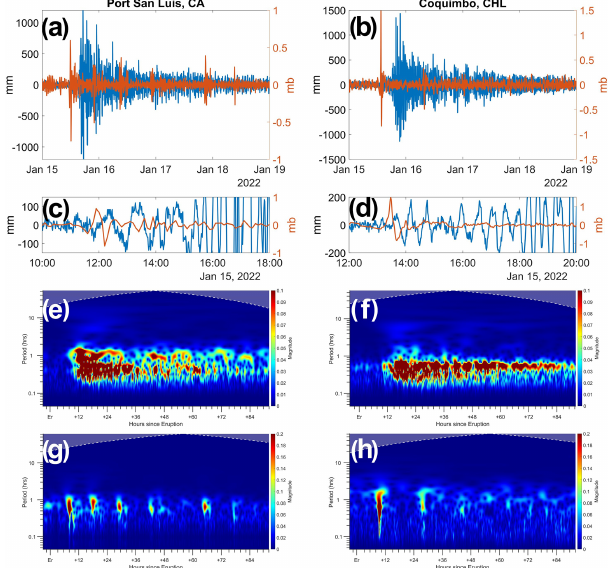
Figure 5. Residual WL (blue, mm) and detrended air pressure (orange, mb) at (a) Port San Luis, California (NOAA Station 9412110), and (b) Coquimbo, Chile; panels (c) and (d) show ex- panded views of panels (a) and (b) of the WL and P A records show- ing the initial arrivals of the VMT and marine tsunami as well as scalograms from CWT analyses of WL in (e) and (f) and for P A in (g) and (h) . Vertical scales in (c) and (d) are set to a small range to highlight the VMT impacts.